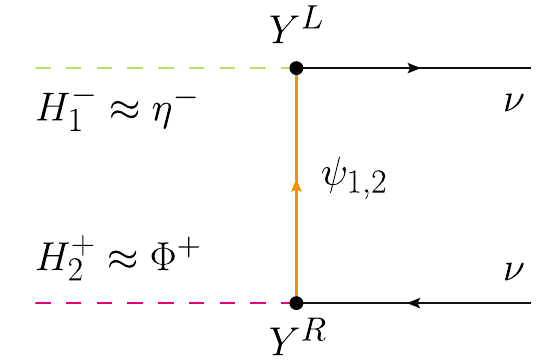
Fig. 3 Dominant diagram contributing to the co-annihilation channel → νν . Notice that both Yukawa matrices, Y L and Y R , must H − H + . Magenta points 1 2 R have sizable entries to make this process